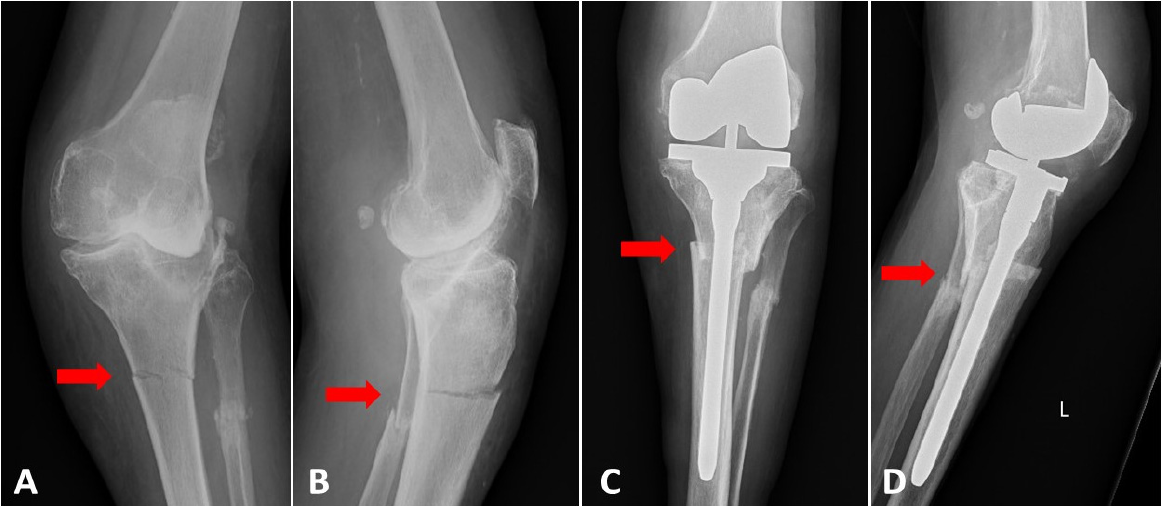
Figure 6. ( A ) AP and ( B ) lateral radiograph of the patient with the fracture of 1/3 proximal of the tibial shaft with coexisting severe osteoarthritis and valgus knee. Postoperative ( C ) AP and ( D ) lateral knee radiographs. The fracture was fixated intramedullary with the use of a well-fitted long-stemmed TKA. Postoperative radiograph indicates that the use of 4 mm tibial offset on the lateral site direction could improve the alignment of bone fragments.